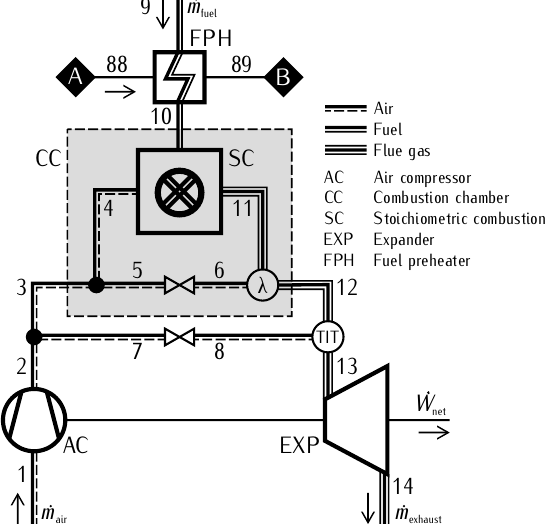
Figure 1. Thermodynamic model of the gas turbine